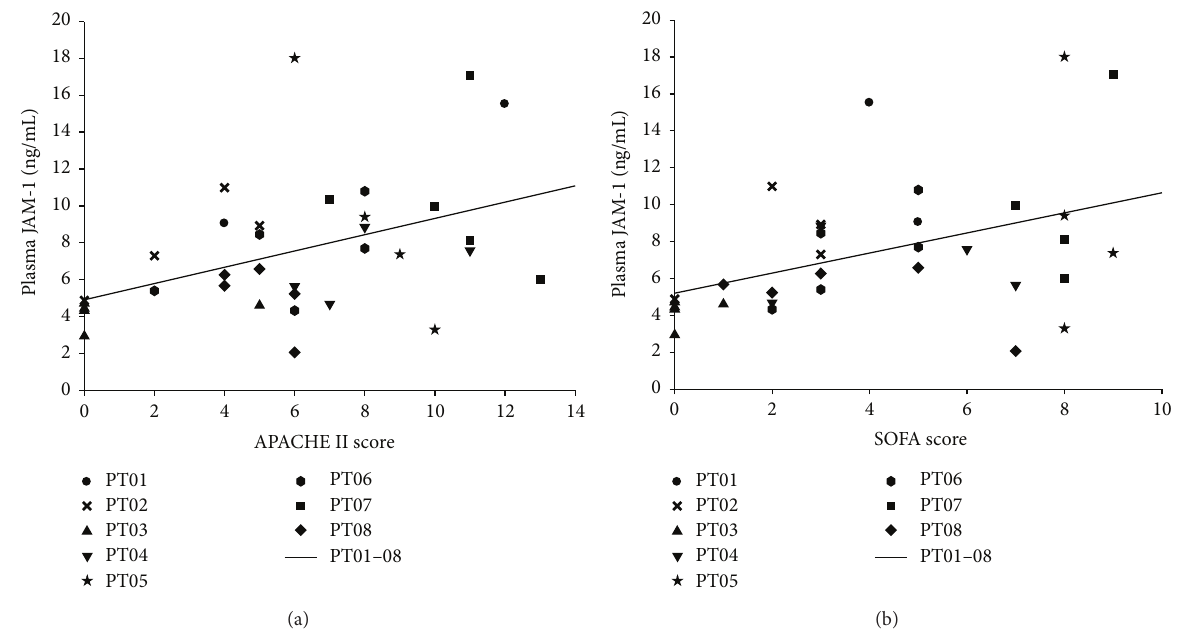
Figure 4: Correlation analysis between JAM-1 plasma levels of polytrauma patients (up to 10d after trauma) and (a) the APACHE II score (Pearson correlation coefficient 𝑟 = 0.50 , 𝑃 = 0.01 ) and (b) SOFA score (Pearson correlation coefficient 𝑟 = 0.37 , 𝑃 < 0.04 ).